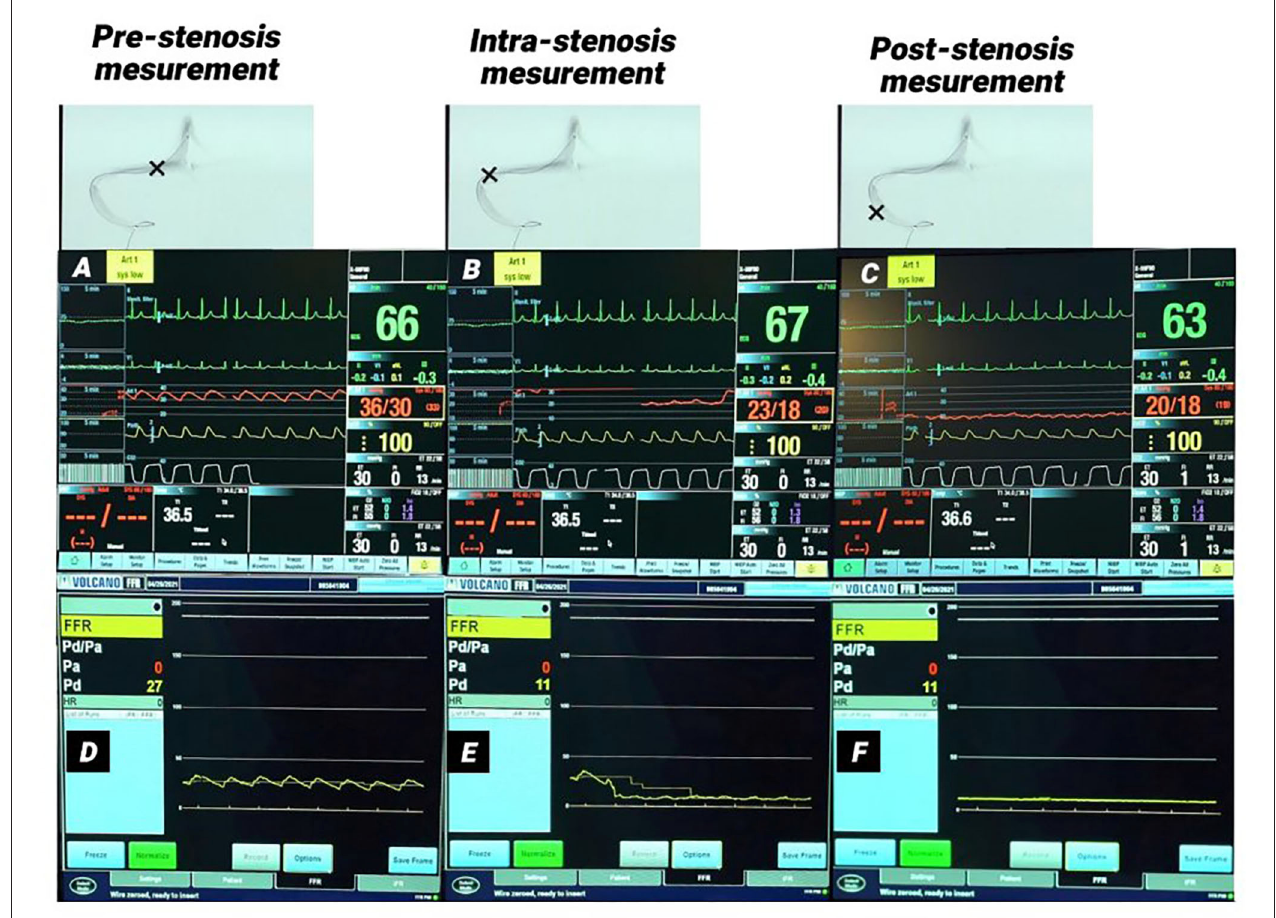
FIGURE 1 | Monitor picture of arterial and pressure wire measurements in a patient with right transverse-sigmoid sinus stenosis. (A–C) Monitor pictures of the arterial line measurements pre-stenosis (A) , intra-stenosis (B) , and post-stenosis (C) . (D–F) monitor pictures of pressure wire measurements pre-stenosis (D) , intra-stenosis (E) , and post-stenosis (F) . A significant pressure gradient was measured in both methods. (B,E) Demonstrate the pressure drop in both measurements at the time the lesion was crossed.